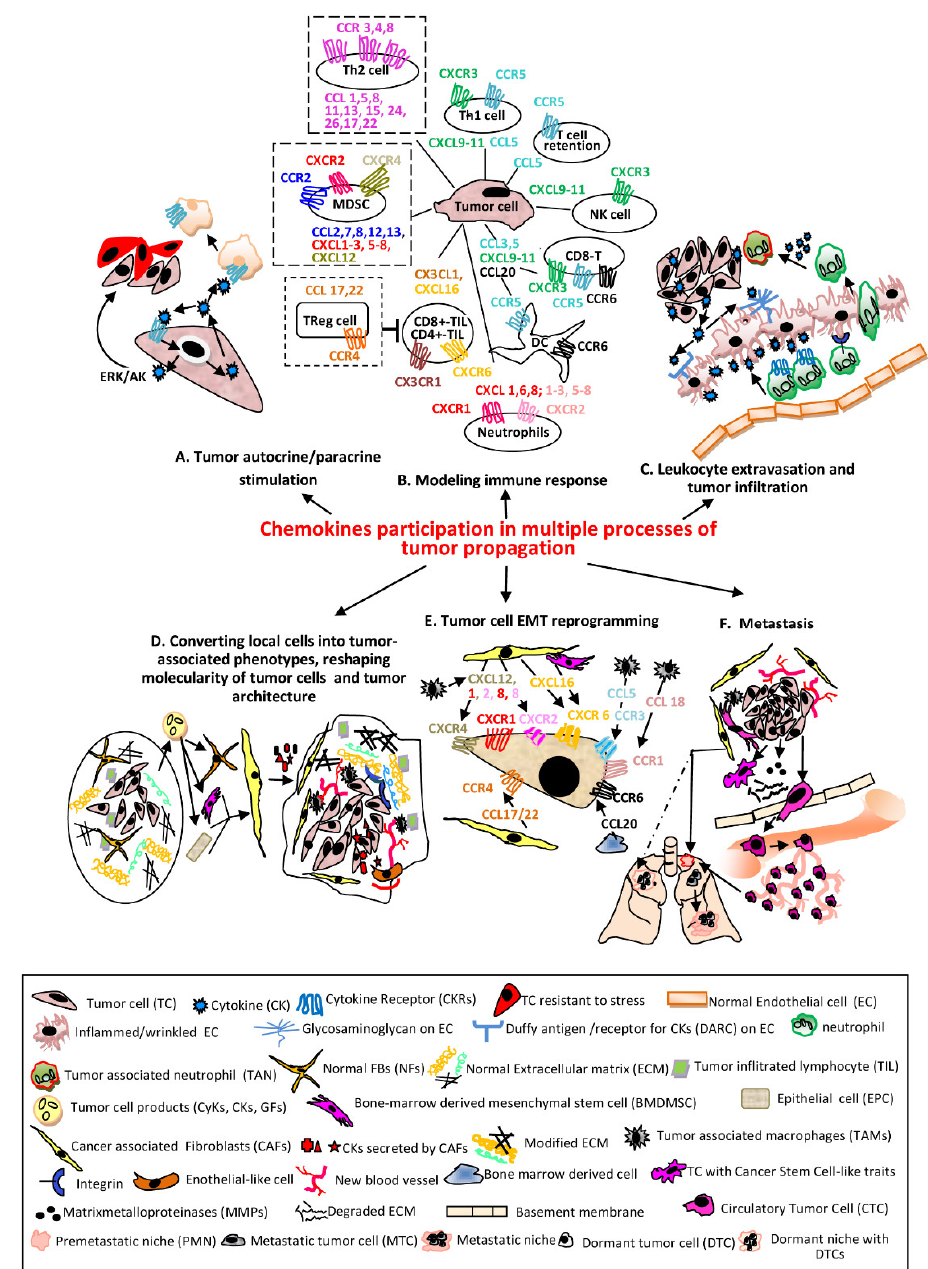
Figure 1. The main processes regulated in various cellular phenotypes by CKs in tandem with their receptors. ( A ) TCssynthetize and secrete CKs which bind to self CKRs or CKRs expressed by other cells resulting activation of signaling pathways which sustain proliferation, survival and stress-resistance of the same TC (autocrine) or adjacent phenotypes (paracrine) [5]. ( B ) The CKs secreted by TCs recruit different immune cells in tumor micro environment (TME). The most relevant and documented examples of CKs/CKRs axes are presented. The pro-tumoral asso- ciated with poor prognosis are shown with dotted lines (NK—natural killer; Th1/Th2-CD4 + T lymphocytes helper type1/type2; CD8 + /CD4 + -TIL-CD4 + /CD8 + Tumor infiltrating lymphocyte; Treg-Regulatory T cell; MDSC—myeloid derived suppressor cell; DC—dendritic cell) [6,7]. ( C ) CKs secreted by TCs bound to the receptors (glycosaminoglycans and Duffy antigen) of inflamed (wrinkled) ECs are transcytosed and accumulated onto luminal face of ECs; the leucocytes migrate into lumen of the vessel toward CKs and establish firm attachments via overexpressed integrins, traverse endothelium through a gap junction or a pore, follow the extracellular CK gradient and